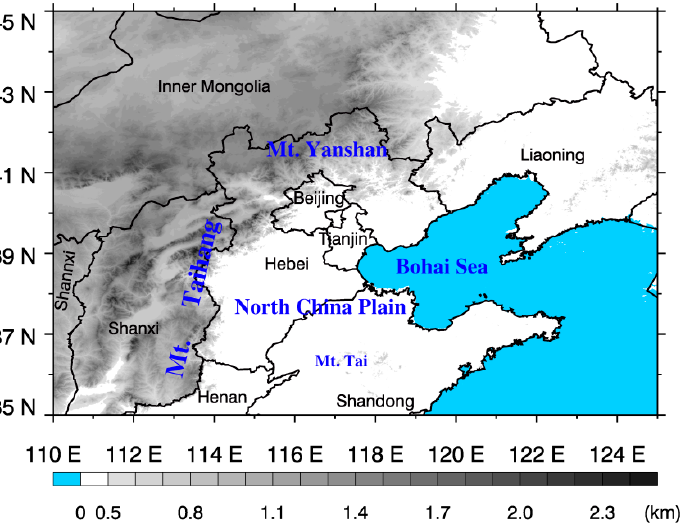
Figure 1. Topographic map (shading, units: km) with names of major landforms and cities/provinces over North China.